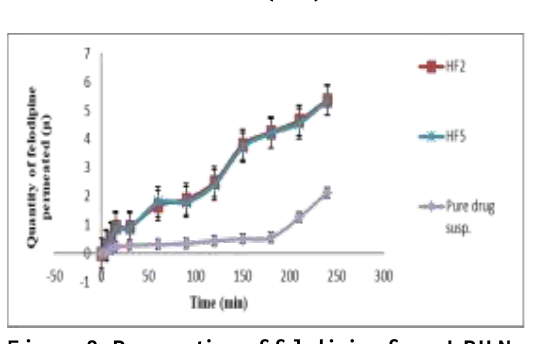
Figure 8. Permeation of felodipine from LPHNs formulations HF2, HF5 and pure drug suspension through non-everted sheep intestine, the values of mean ±SD (n=3).